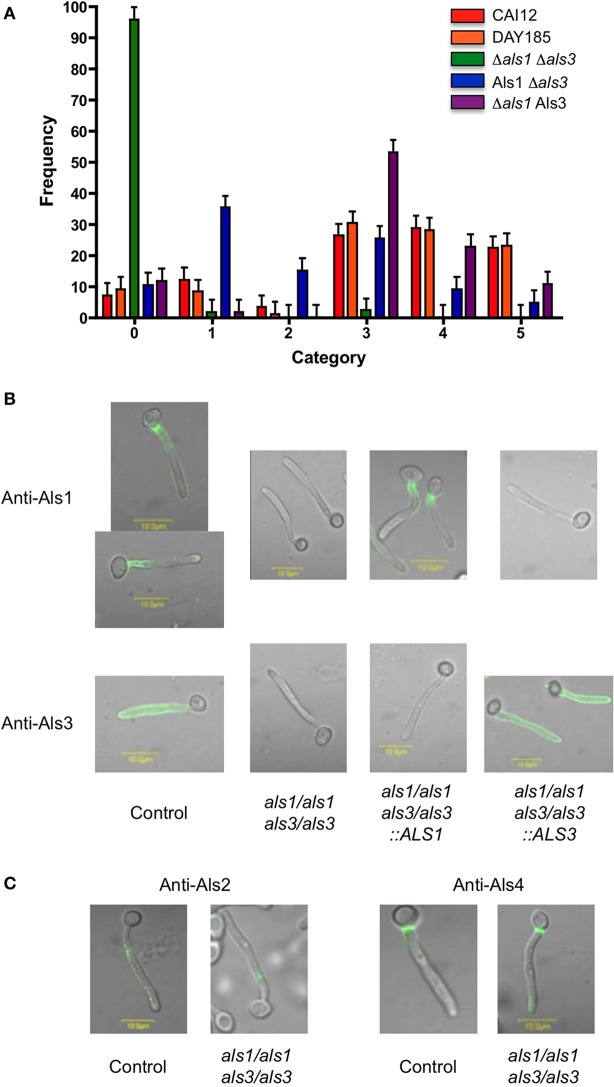
S. gordonii co-aggregation with C. albicans strains lacking Als1, Als3 or both proteins. (A) The co-aggregation assay was conducted and analyzed as described above. William Fonzi, Georgetown University, provided C. albicans control strain CAI12 (ALS1/ALS1 ALS3/ALS3; Porta et al., 1999). Aaron Mitchell, Carnegie Mellon University, provided strains DAY185 (ALS1/ALS1 ALS3/ALS3; Nobile et al., 2008), Δals1 Δals3 (CJN1348; als1/als1 als3/als3; Nobile et al., 2008), Als1 Δals3 (CJN1352; als1/als1::ALS1 als3/als3; Nobile et al., 2008), and Δals1 Als3 (CJN1356; als1/als1 als3/als3::ALS3; Nobile et al., 2008). All assays used S. gordonii strain SspB. The full set of comparisons between means is provided as Table 2 in Supplementary Material. (B)
C. albicans hyphae were grown for 90 min, then immunolabeled with a monoclonal antibody that recognizes either Als1 (Coleman et al., 2010) or Als3 (antibody 3-A5; Coleman et al., 2009). Genotypes of each strain are shown below the images. (C)
C. albicans hyphae were grown for 90 min and immunolabeled with a monoclonal antibody that recognizes either Als2 or Als4 (Coleman et al., 2012). Methods for immunolabeling of C. albicans germ tubes and for fluorescence microscopy and image processing were published previously (Coleman et al., 2009).